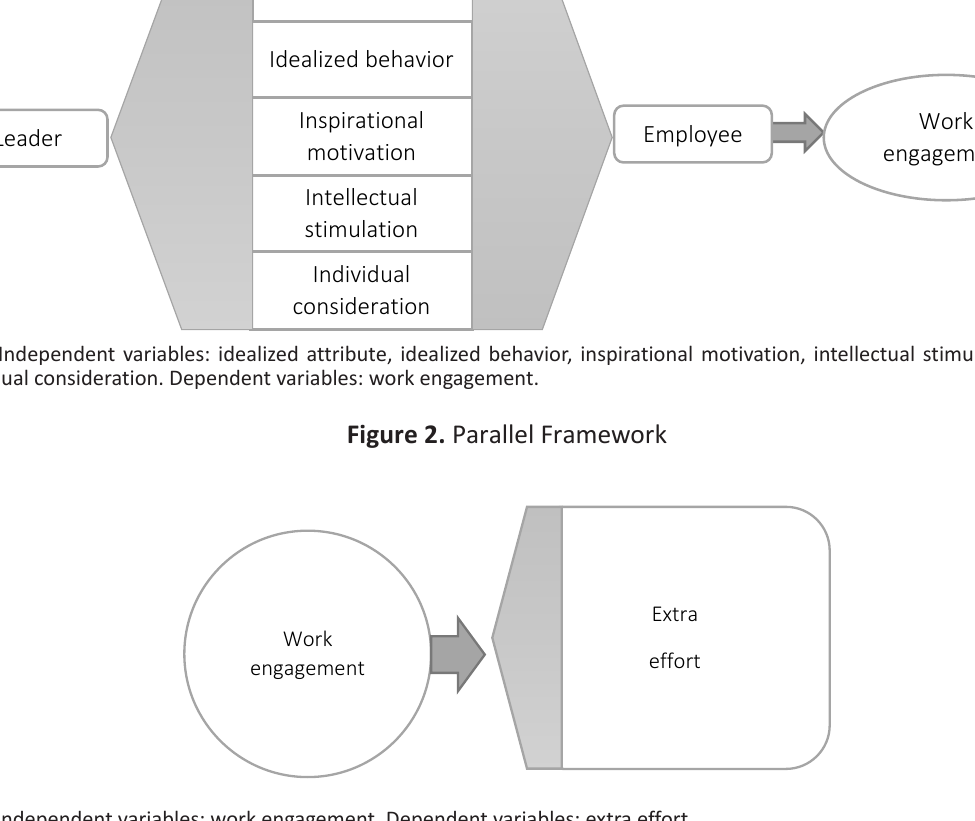
Figure 3. Parallel Framework